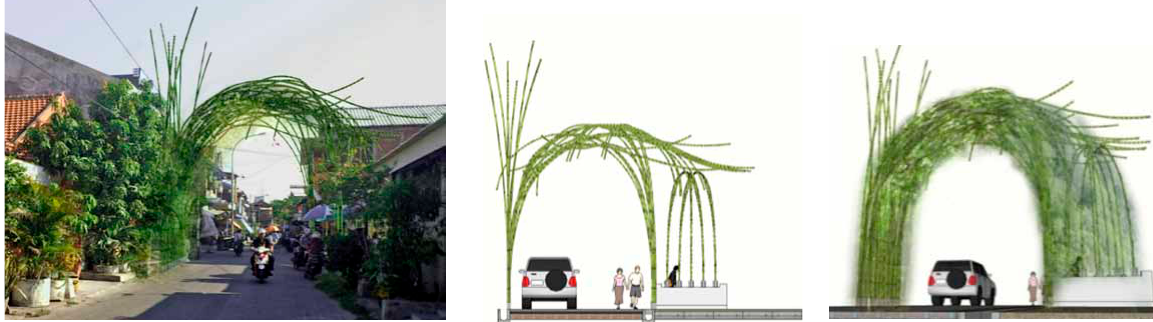
fig. 12. rendered image of suggested design for alley crossing (created by the author)